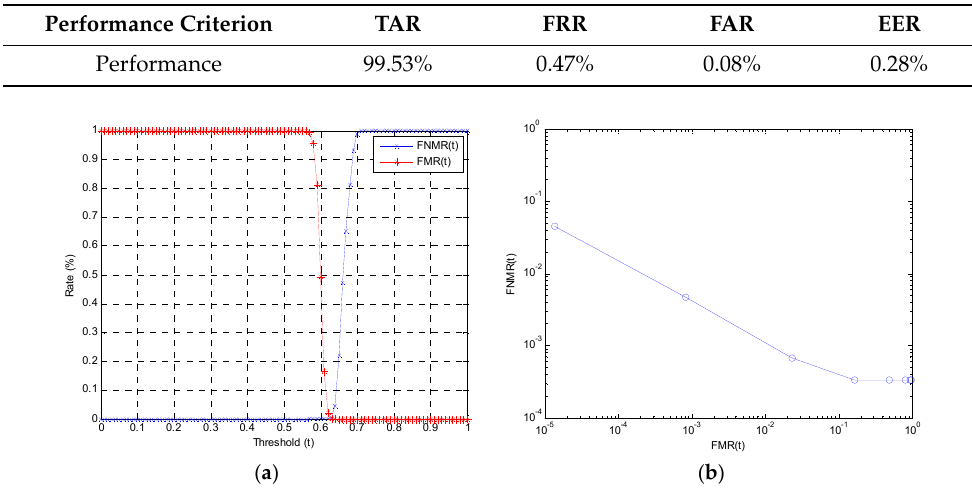
Figure 13. Illustration of the performance evaluation on the PF07 database: ( a ) the distribution of false not-matching rate (FNMR) and false matching rate (FMR) with threshold value t varying from 0.0 to 1.0, and ( b ) the log-log scale receiving operation curve (ROC) with the false not-matching rate and false matching rate.